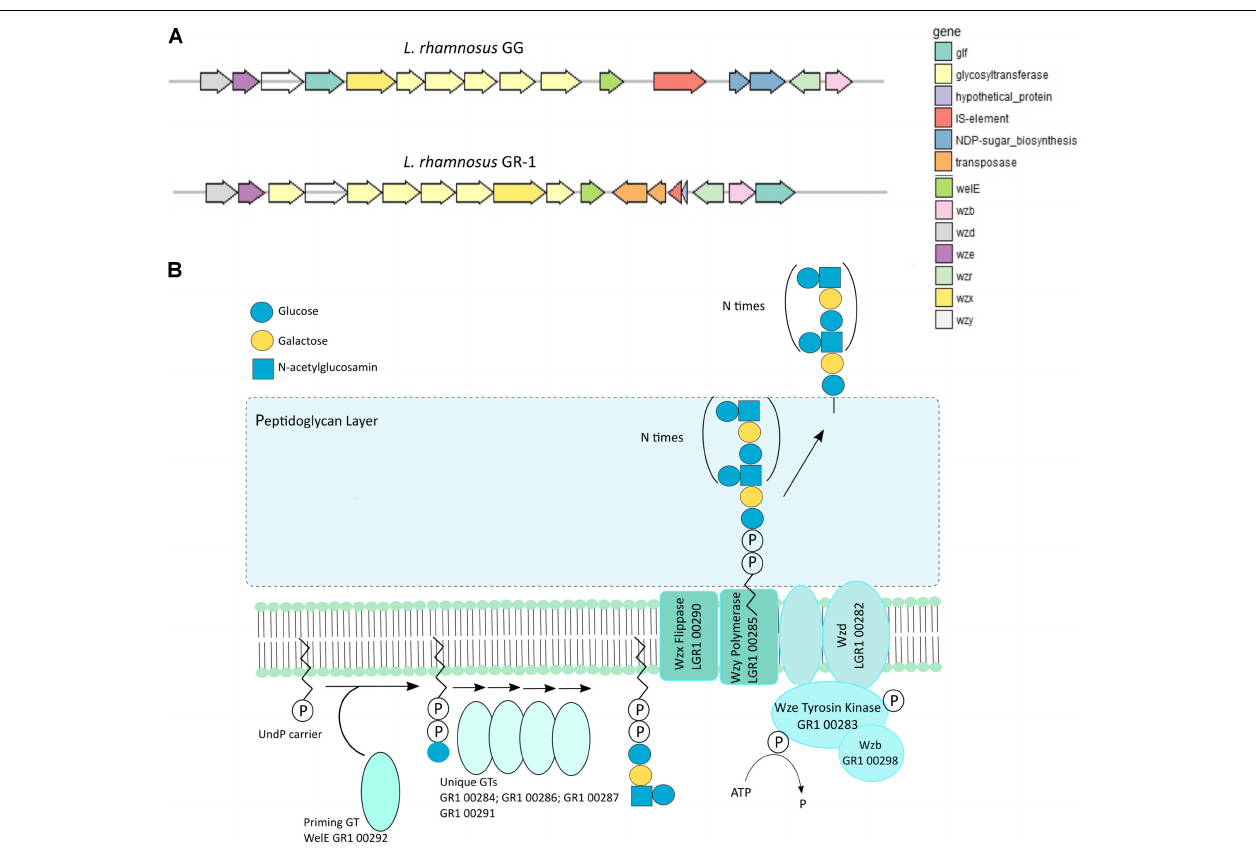
FIGURE 5 | (A) Organization of the EPS gene cluster of L. rhamnosus GR-1 in comparison with the EPS gene cluster organization of L. rhamnosus GG. (B) Schematic representation of the putative steps in EPS biosynthesis by L. rhamnosus GR-1 that are encoded within the EPS gene cluster.